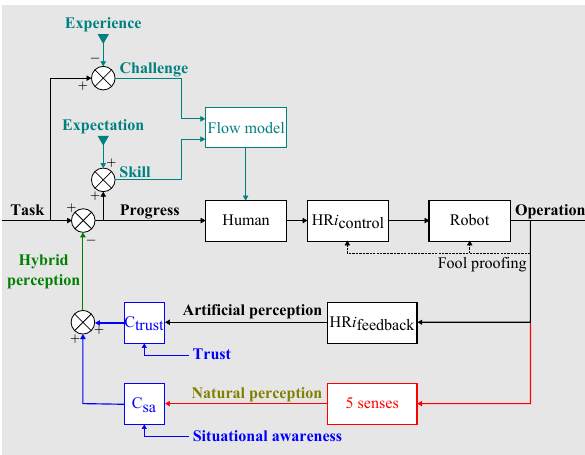
Figure 3: Extended user experience framework includ- ing trust in automation, situational aware- ness, and the Flow